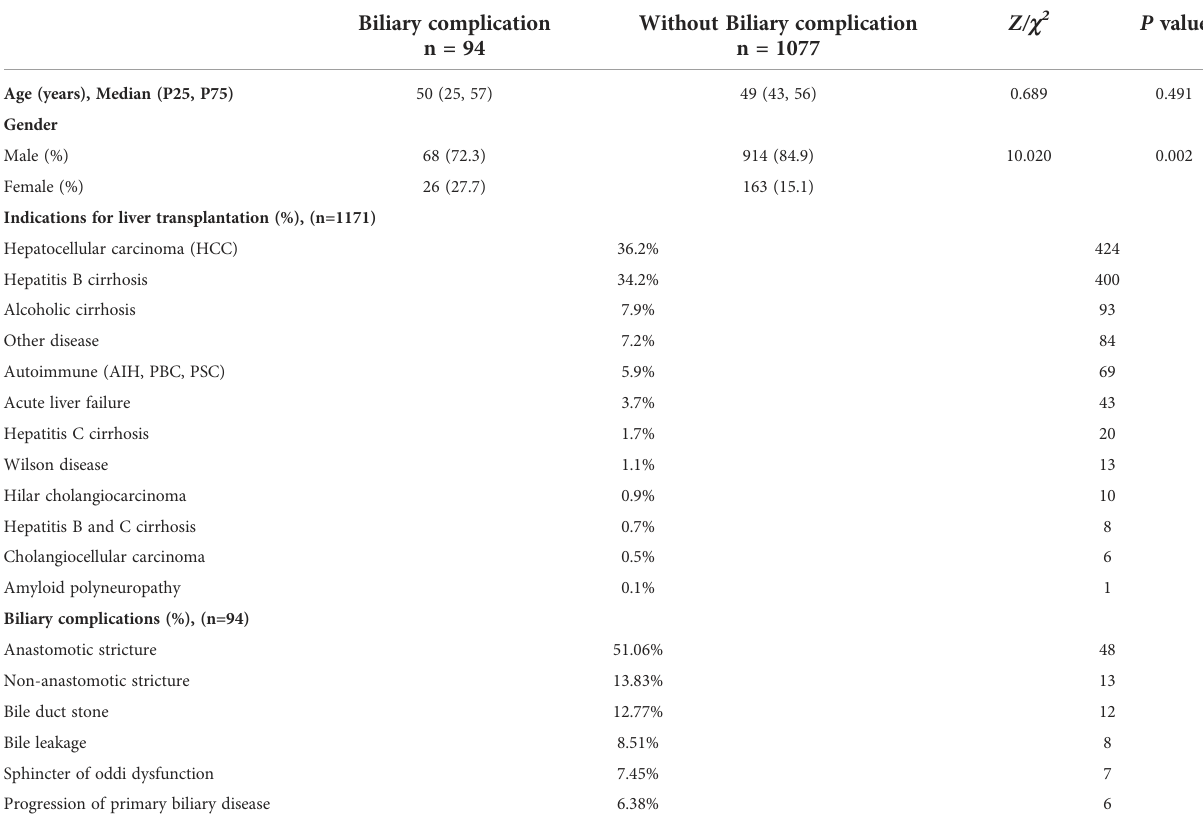
TABLE 1 Baseline characteristics of 1171 liver transplantation patients.